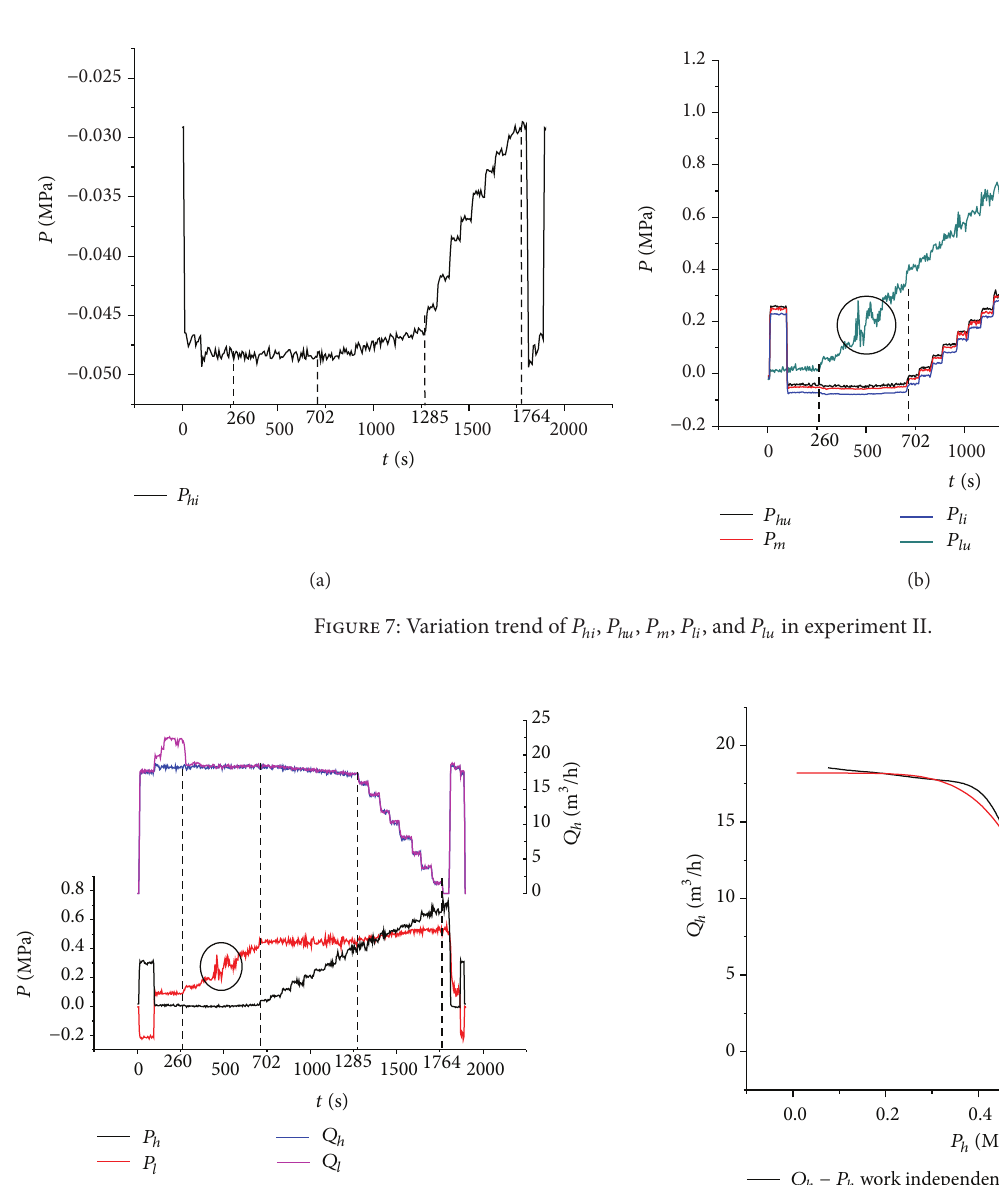
Figure 8: Variation trend of flow and differential pressure in experiment II.